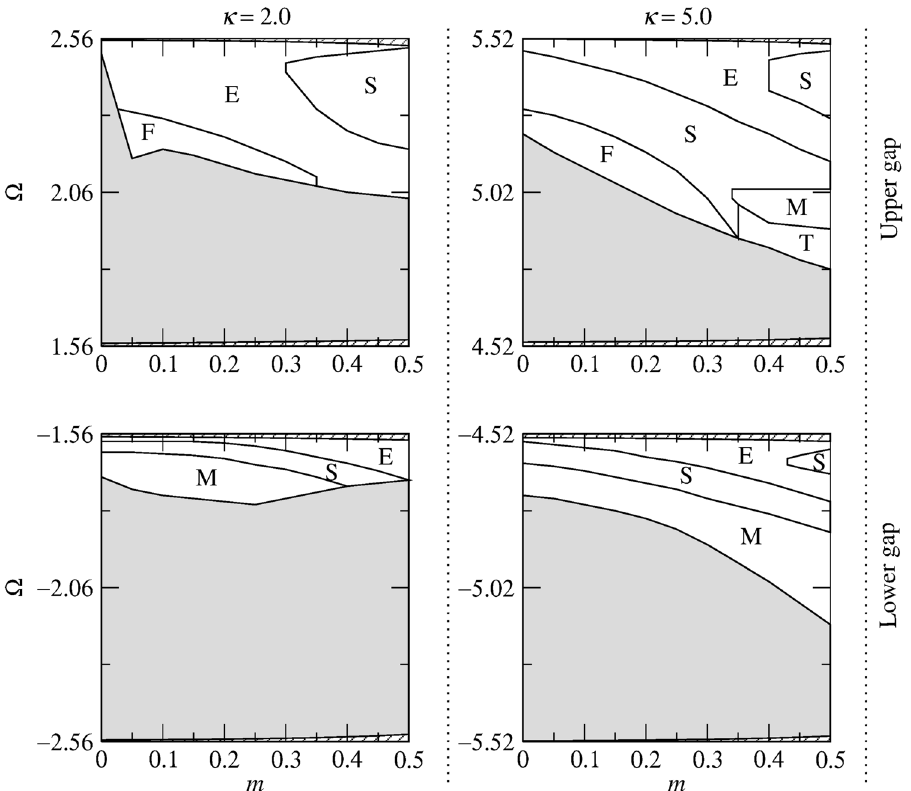
Figure 11. Collision outcome diagrams for in-phase solitons for different values of κ and δ = 0.1, c = 0.2. The regions are labeled as slow symmetric separation (S), fast symmetric separation (F), quasi-elastic separation (E), merger (M) and three soliton generation (T). The shaded areas indicate regions where solitons are unstable. The areas which lie outside the gaps and consequently do not contain soliton solutions are shown by the diagonal